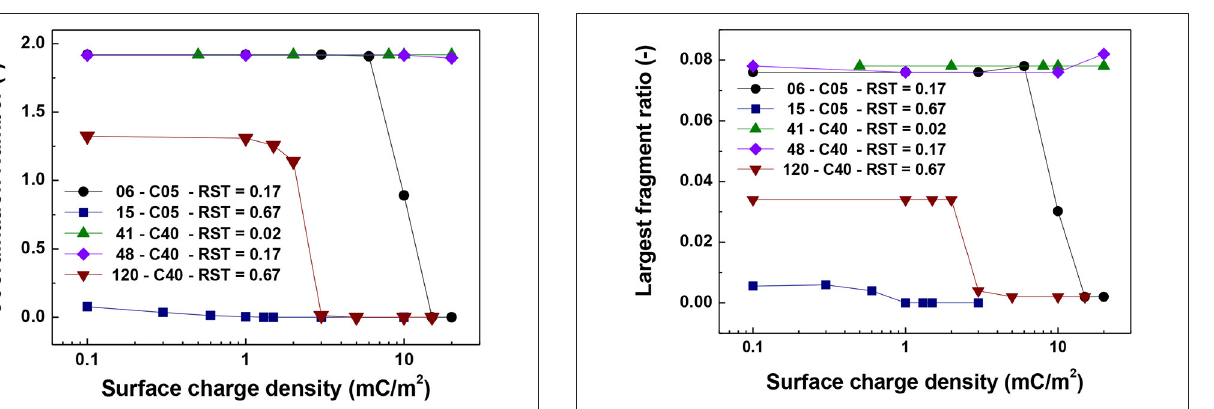
FIGURE 6 | Coordination number vs. surface charge density. The figure presents the comparison for cases of shell thickness equal to 50nm (06-C05 and 41-C40) and two values of relative shell thickness of 0.17 (06-C05, 48-C40) and 0.67 (15-C05 and 120-C40).